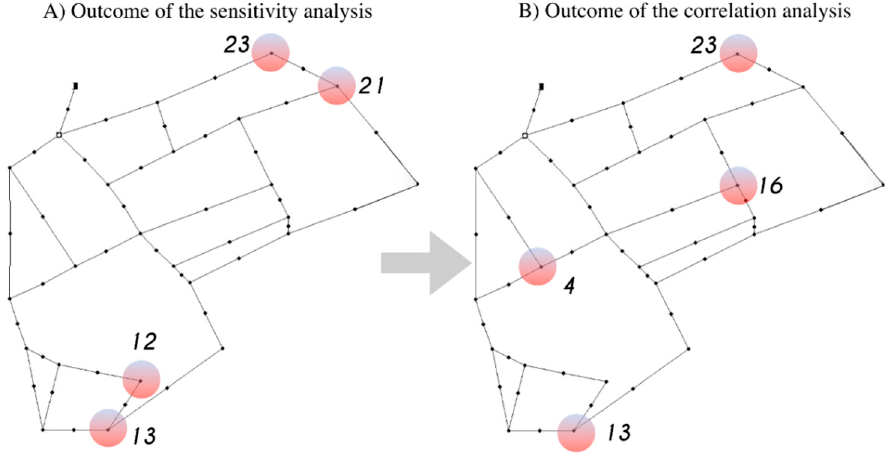
Figure 5. Results of the sensitivity ( A ) and correlation ( B ) analysis.